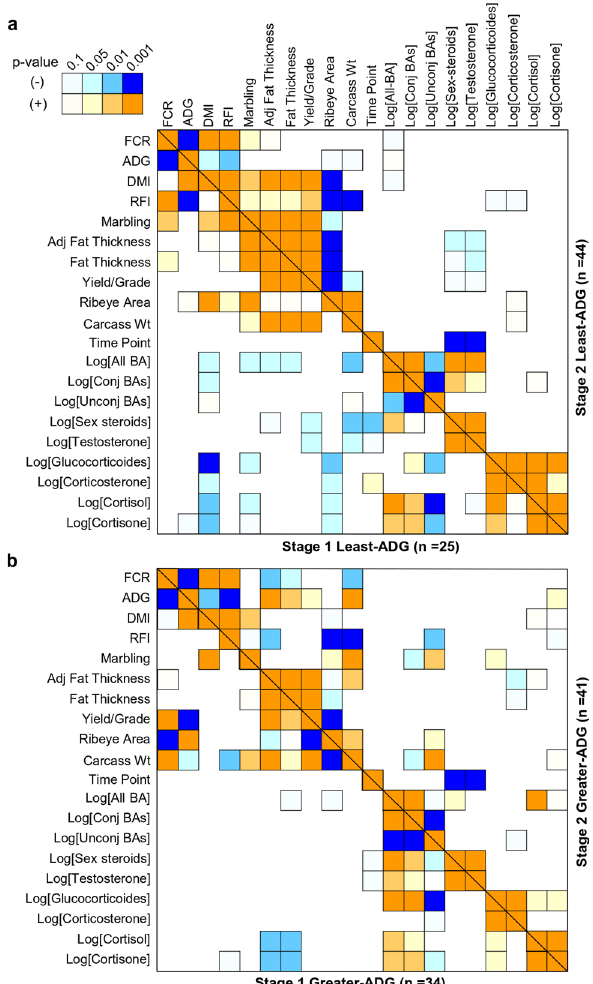
Figure 6. Pearson correlations (r) of bile acids and steroids with productive traits for least ( a ), and greater ( b ) ADG-classification in both